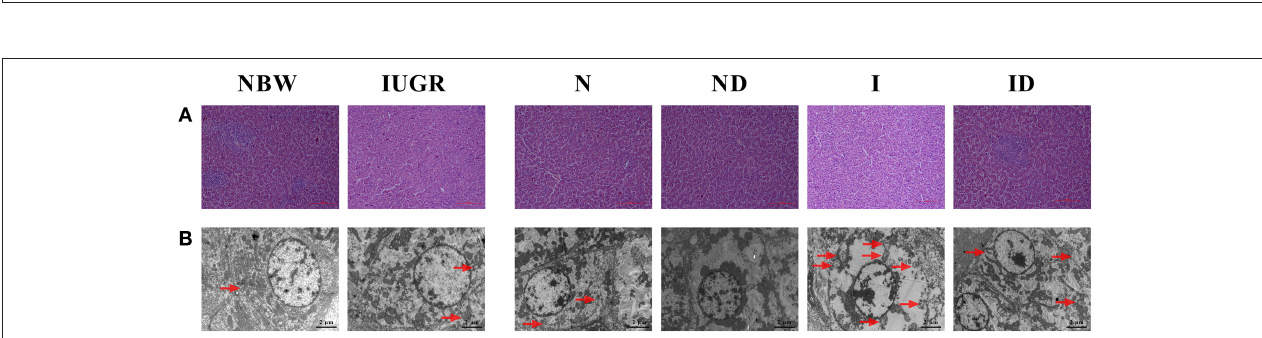
FIGURE 2 | Supplementation with DMG-Na improved the hepatic histological morphology of IUGR suckling piglets. (A) Hematoxylin-eosin staining of the liver; Scale bars represent 100 µ m. (B) Mitochondrial swelling in the liver. Scale bars represent 2 µ m. The mitochondria swelling was indicated by the red arrow. NBW, normal birth weight newborns; IUGR, intrauterine growth restriction newborns; N, NBW newborns fed a basic milk diet; ND, NBW newborns fed a basic milk diet plus 0.1% DMG-Na; I, IUGR newborns fed a basic milk diet; ID, IUGR newborns fed a basic milk diet plus 0.1% DMG-Na.